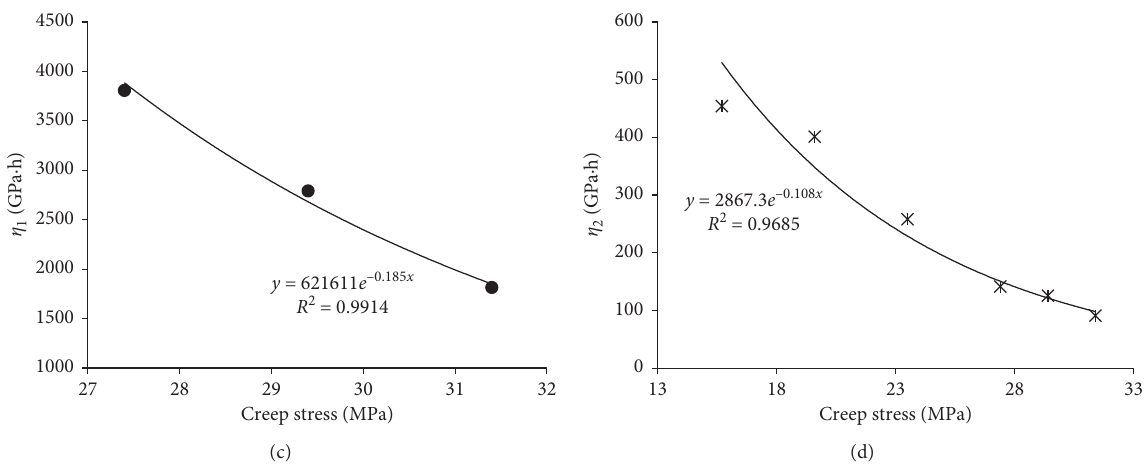
Figure 11: Relationship between creep parameters and creep stress: (a) E